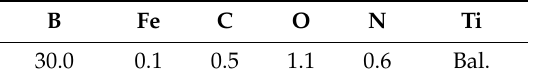
Table 2. Chemical composition of TiB 2 powder